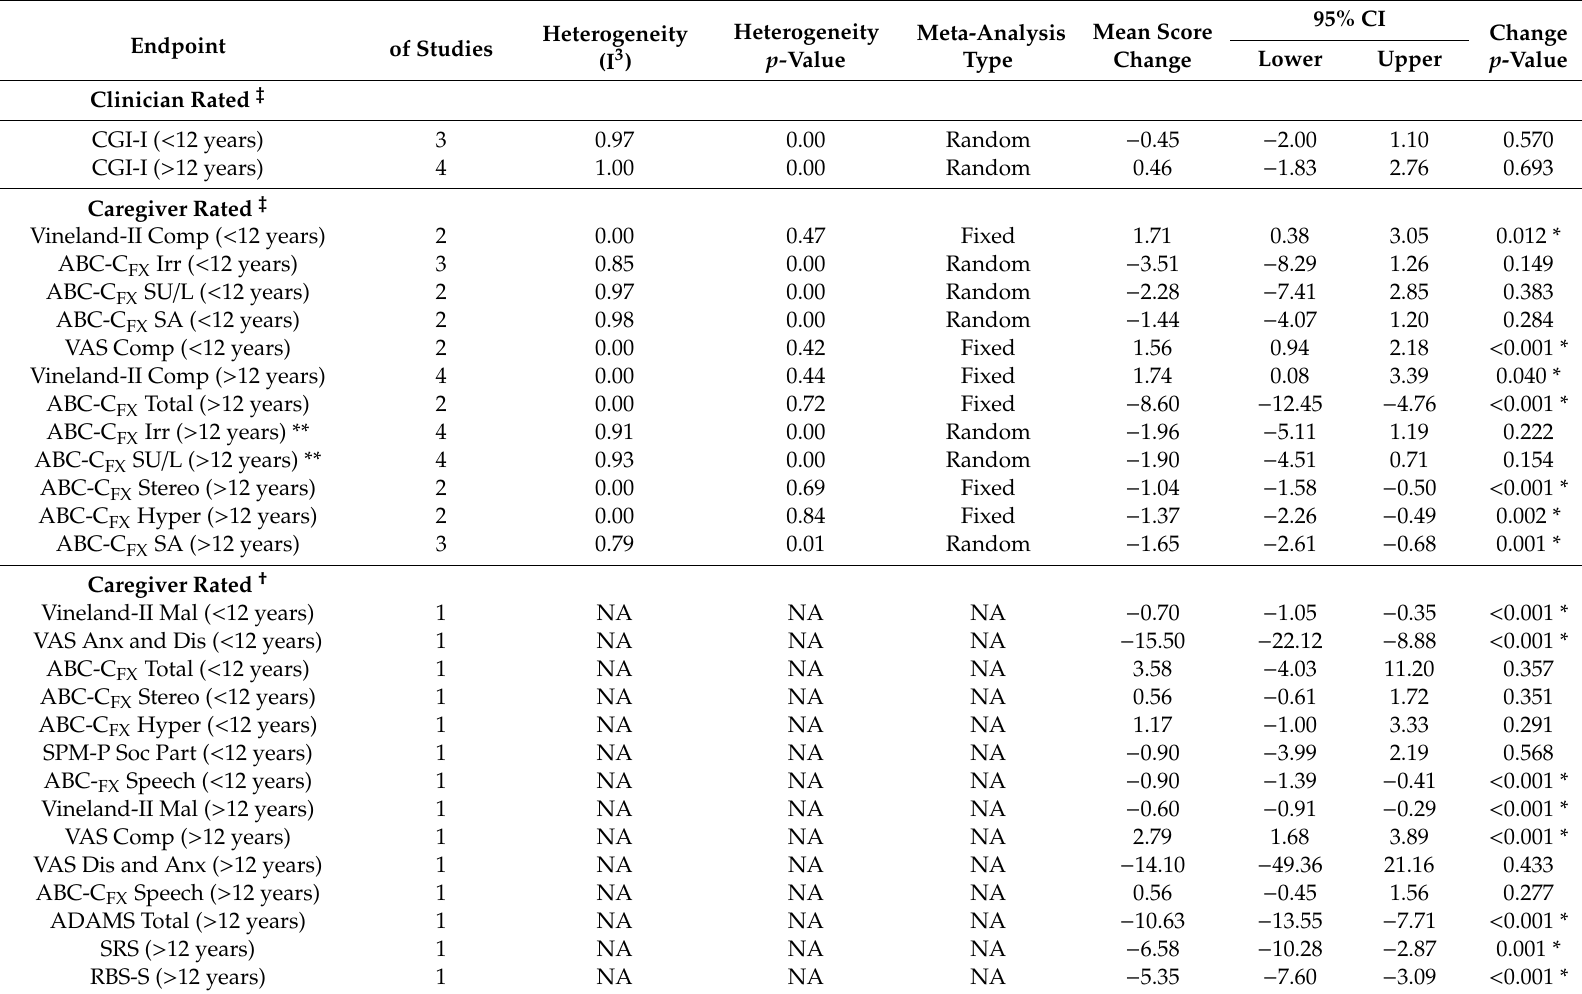
Table 1. Outcome measures changes in placebo-treated groups with FXS in failed clinical trials – Main